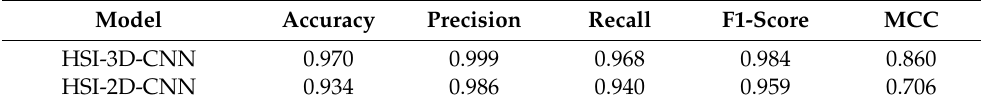
Table 12. Comparison of classification results of 3D-CNN and 2D-CNN models trained by HSI data.